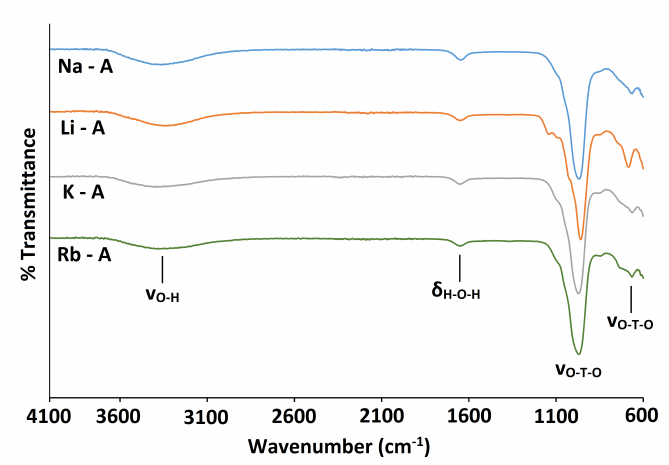
Figure 5. FT-IR spectra for Na-A (blue line) and cation-exchanged Li-A (orange line); K-A (grey line) and Rb-A (green line).